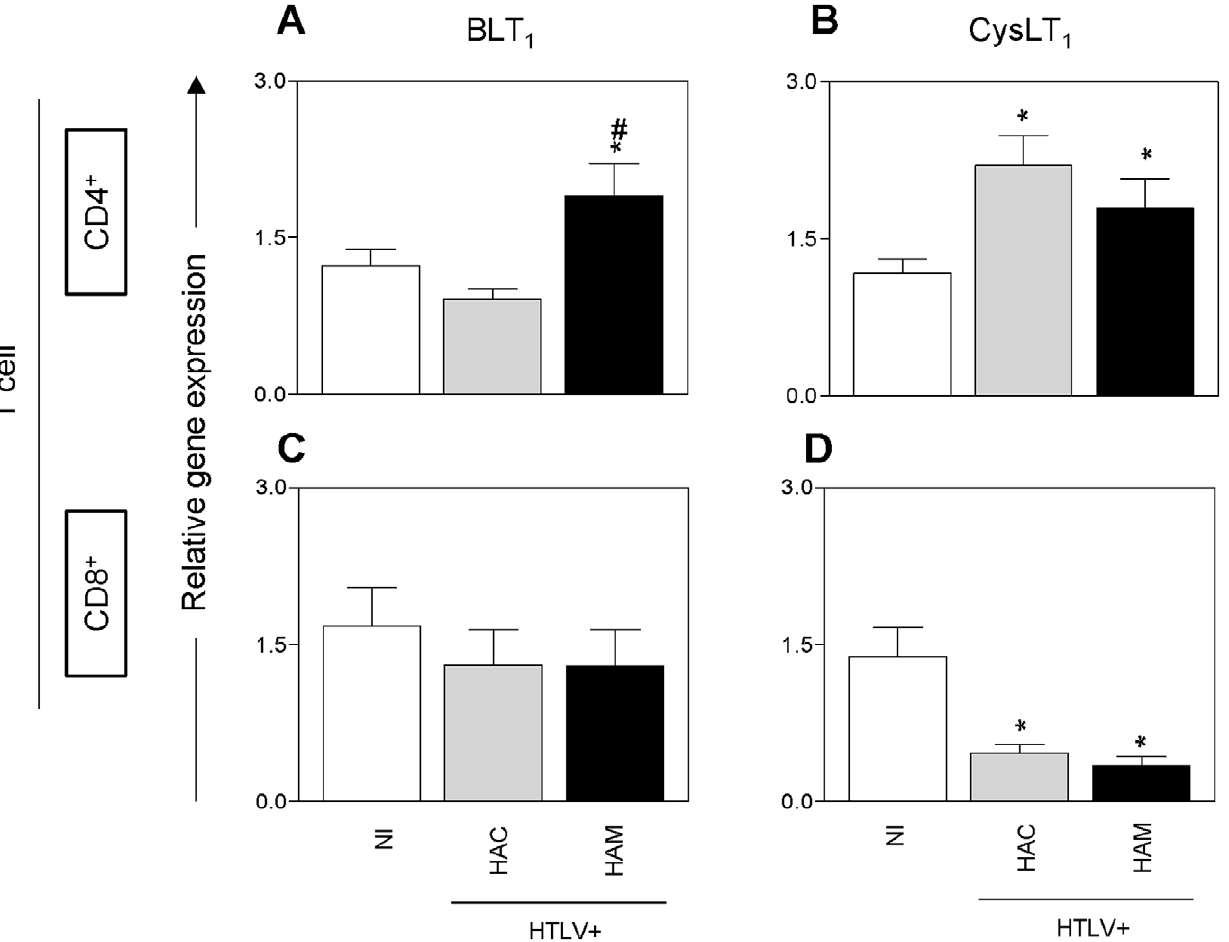
Figure 3. Leukotriene receptor mRNA expression in lymphocytes of HTLV-1 patients. Quantitative PCR (qPCR) was performed for BLT 1 (A, C) and CysLT 1 (B, D), and their relative expression levels were determined in CD4 + (A, B) and CD8 + (C, D) T cells from twenty non-infected healthy donors (NI), twenty asymptomatic carriers (HAC) and seventeen HAM/TSP patients (HAM). Gene expression levels were normalized to the gene expression levels of ACTB, GAPDH, B2M and RPL13a for CD4 + T cells and of ACTB for CD8 + T cells in the same real-time PCR reaction. The data are presented as means 6 SEM. * p , 0.05, compared with NI donors; # p , 0.05, compared with HACs (one-way ANOVA).